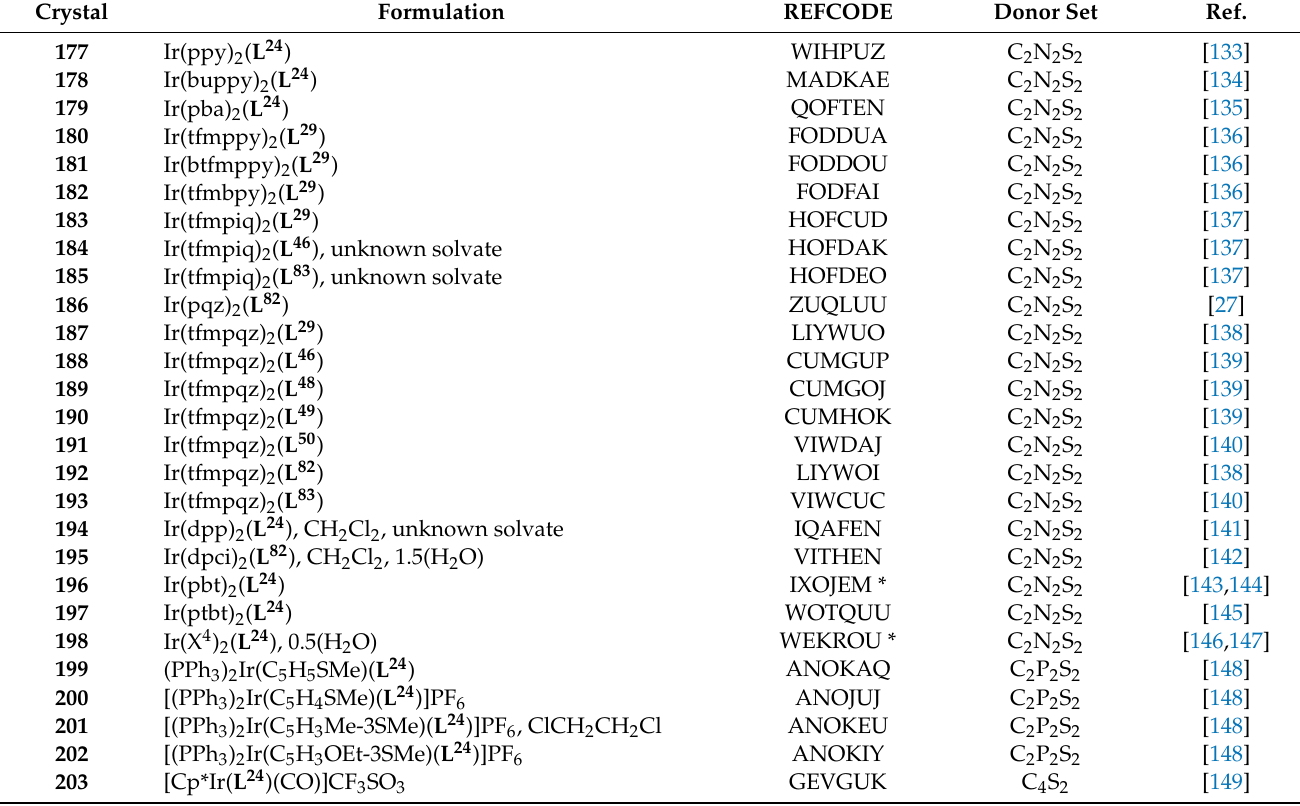
Table 6. Summary of iridium dithiocarbamate structures established by X-ray crystallography. See Table 1, Figure 2, and the Abbreviations